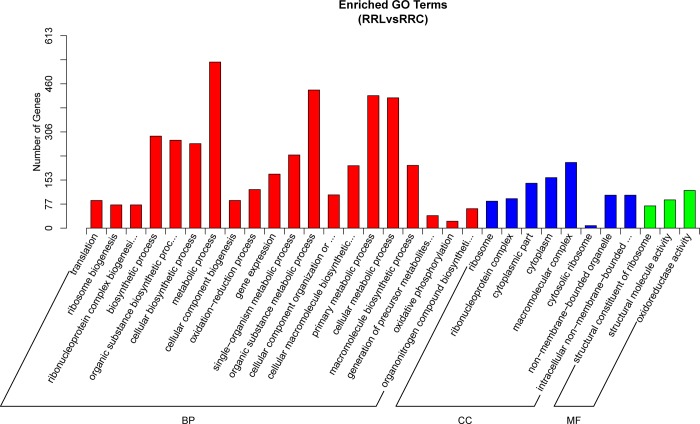
Functional annotation of differentially expressed genes based on Gene Ontology (GO) classification.